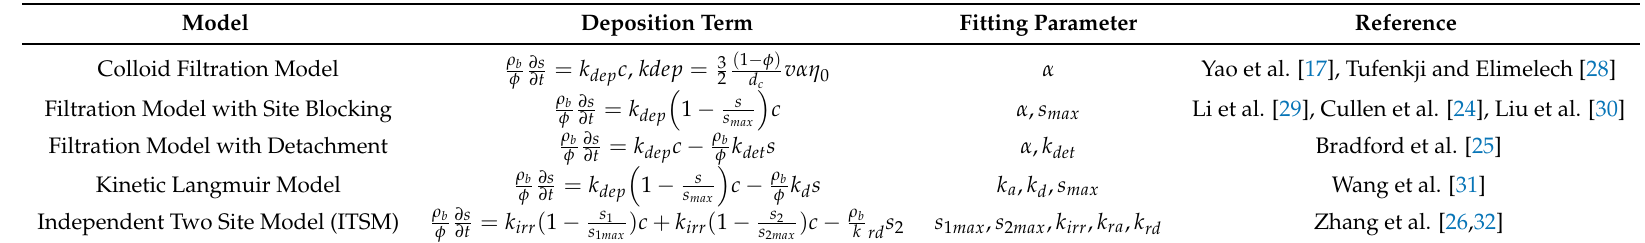
Table 1. Nanoparticle deposition models